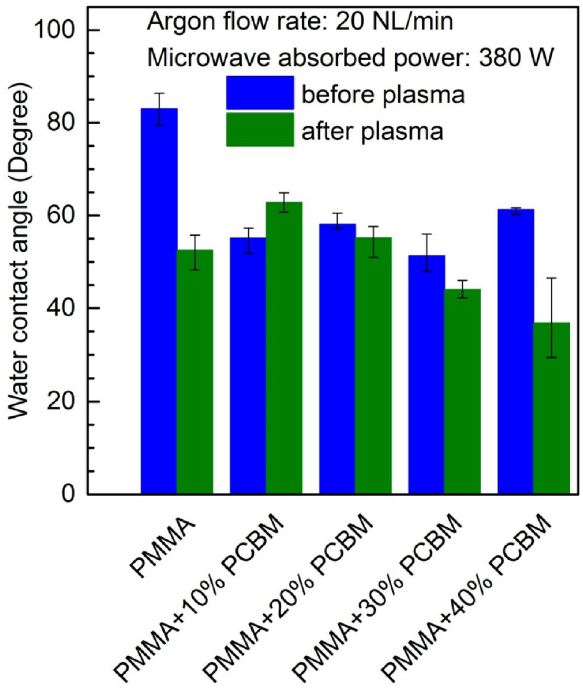
Figure 6. Effect of the plasma surface modification of PMMA polymer and PMMA + PC 61 BM composites on the water contact angle. Number of scans: 1. Argon flow rate 20 NL/min. Microwave power 380